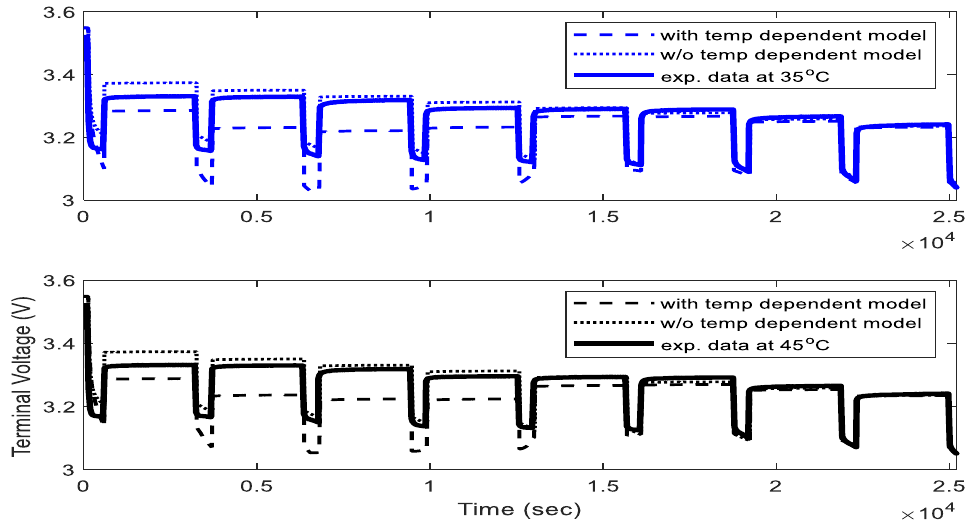
Figure 25. Terminal voltage at different ambient temperature (35 °C and 45 °C).